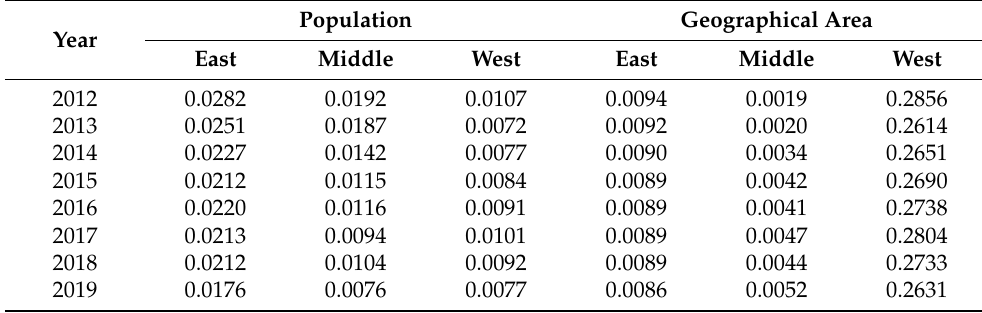
Table 9. Theil indices of Chinese GPs in the east, middle, and west regions. Population Geographical Area Year East Middle